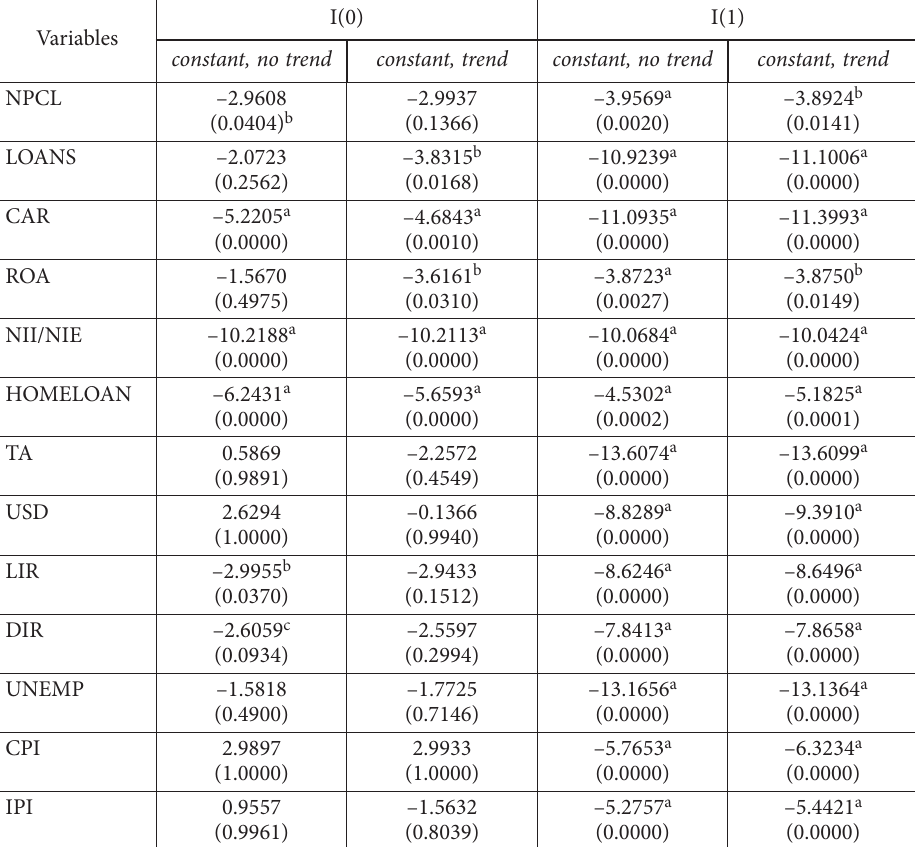
Table 3. ADF unit root test results (source: own calculation of